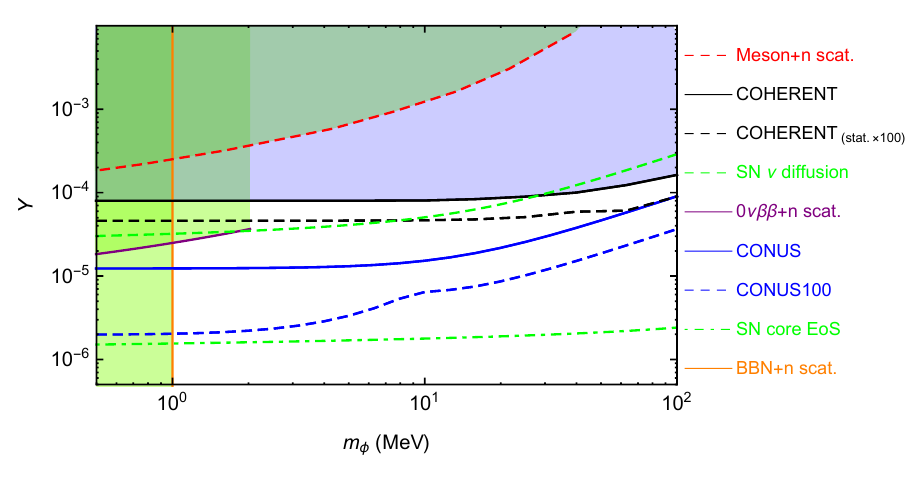
Figure 5 . Similar to (cid:12)gure 4 but for lepton number violating interactions, see eq. (2.2).